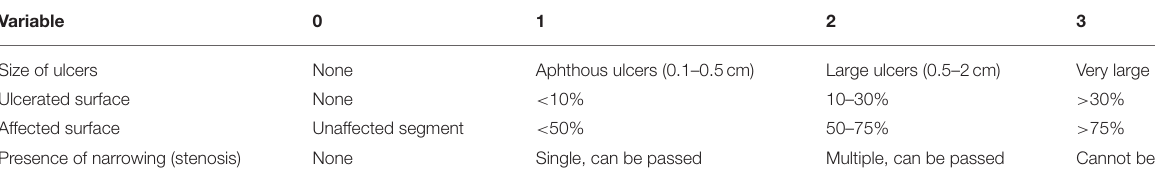
TABLE 2 | Simple endoscopic score for Crohn’s disease (CE-CD) (51).